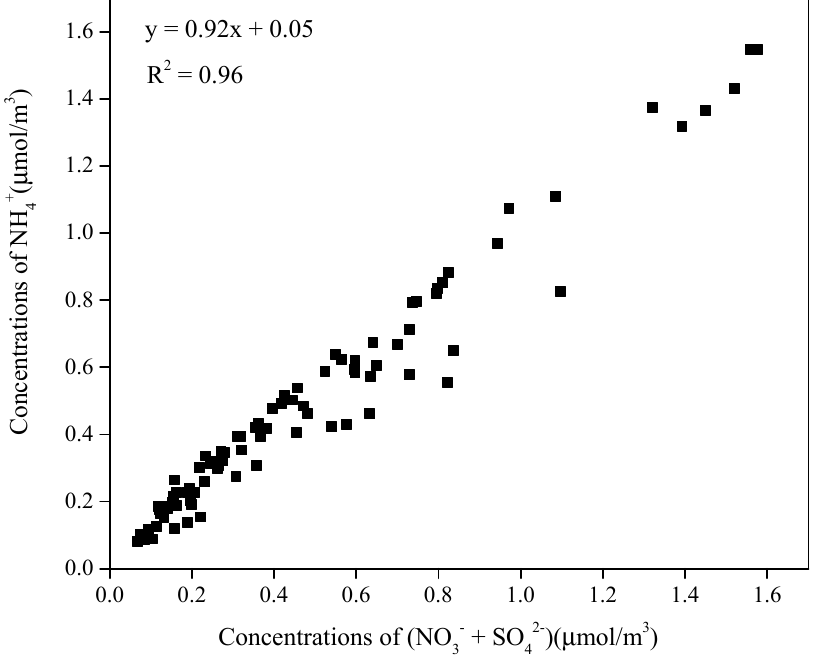
Figure 6. Concentrations of NH 4+ versus and sum of SO 42 − and NO 3 − .